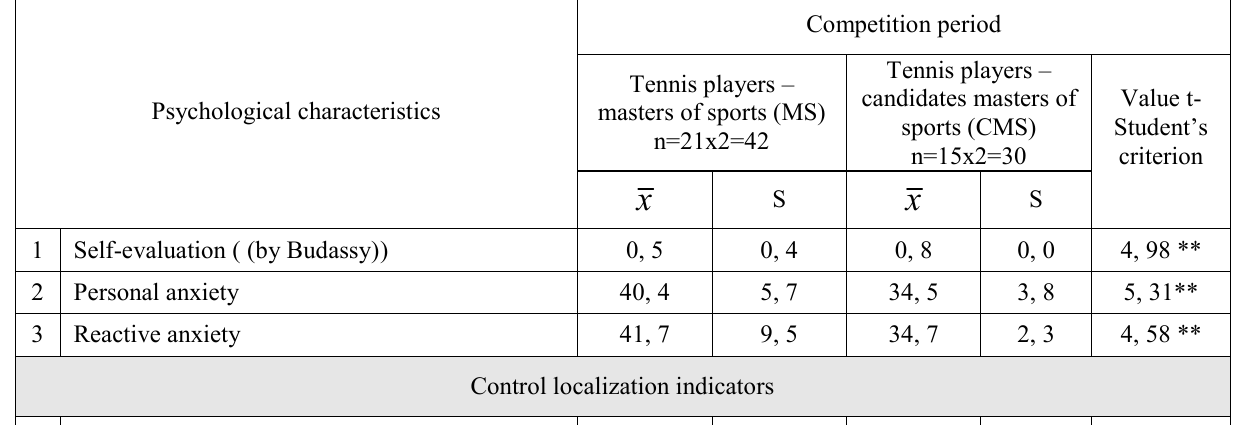
Indicators of psychological characteristics of tennis players of different qualification (competition